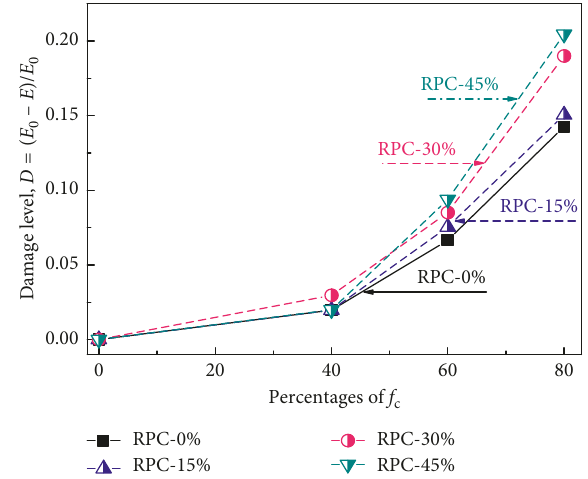
Figure 10: RPC damage level after suffering different applied